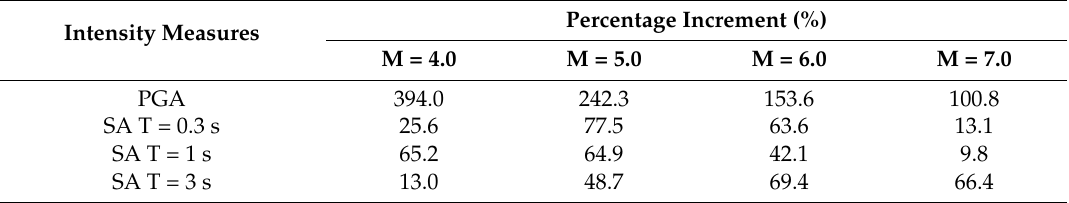
Table 5. Percentage increments of the predictions of SI17hyb with respect to SI17ref.